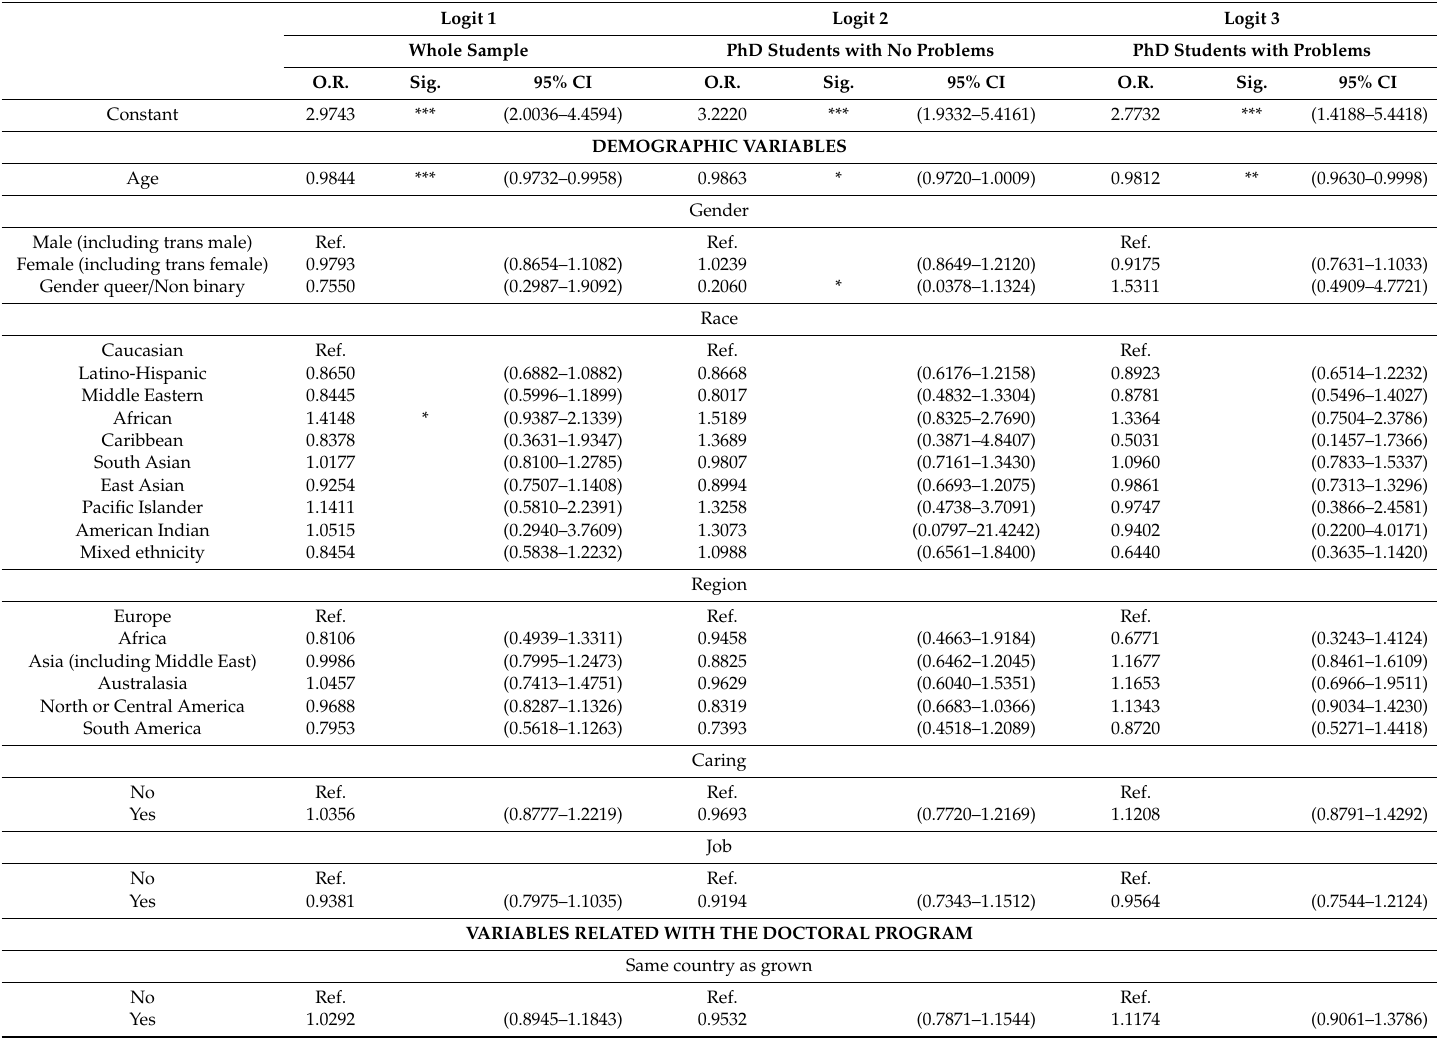
Table 1. Binomial logistic regressions (endogenous variable: Do nothing vs. Change area / supervisor / not pursue a PhD)